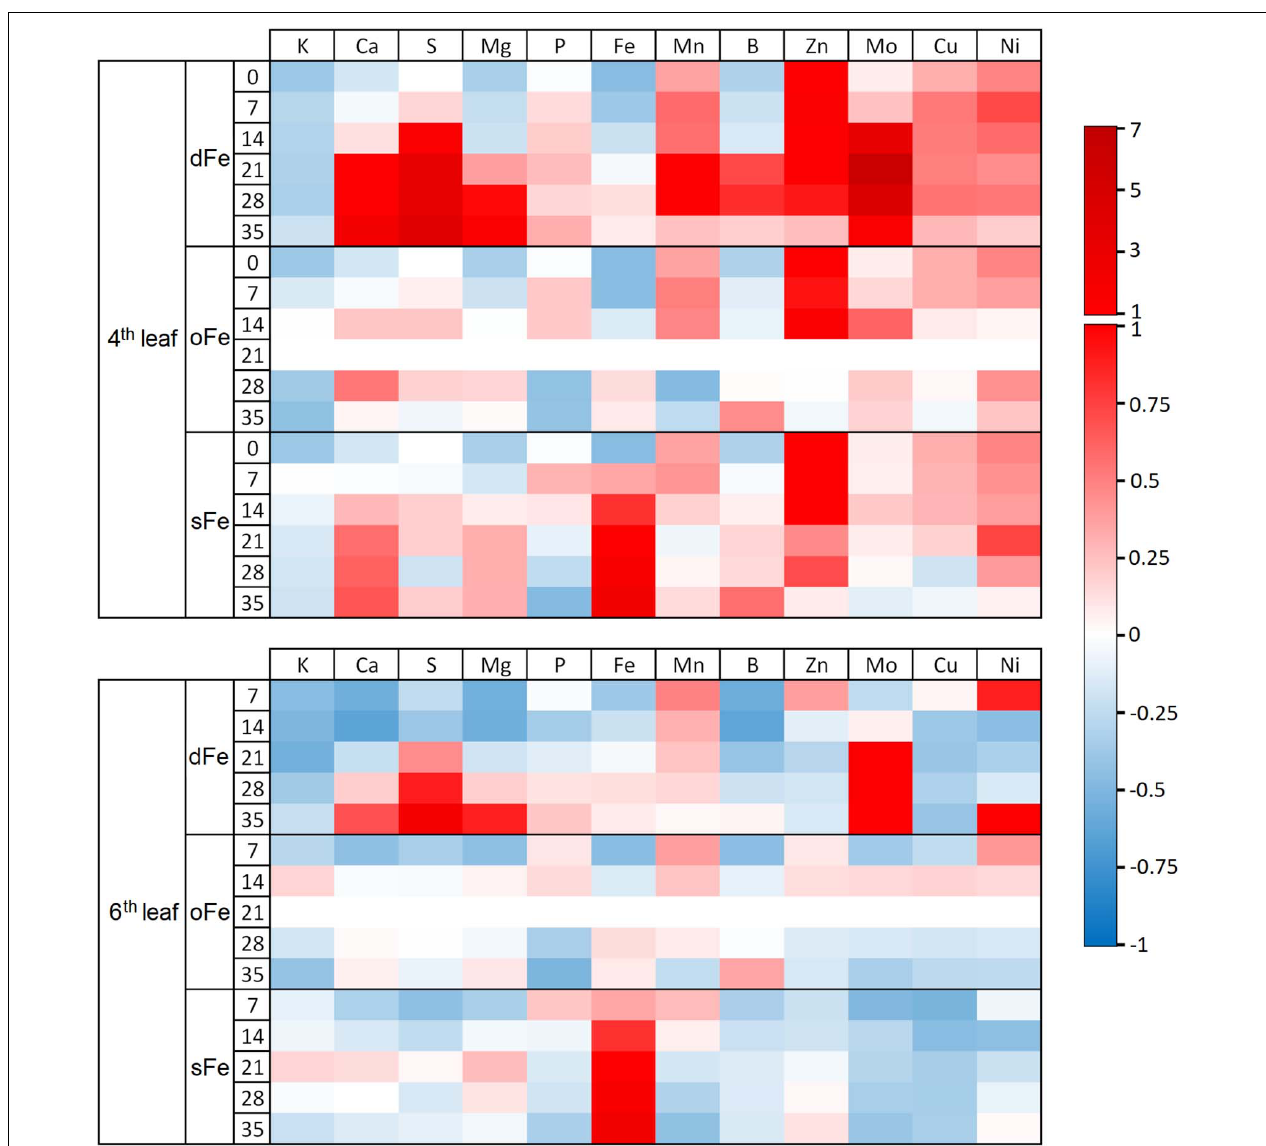
FIGURE 1 | Heat map of the element accumulation of the 4th and 6th leaves of plants grown on deficient (dFe), optimal (oFe) and supraoptimal (sFe) Fe supply. Heat map plot indicates the concentration of elements as deviance from the total corresponding accumulation in oFe leaves at the 21st day of treatment (zero